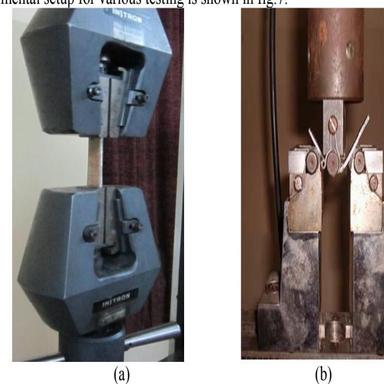
and b shows the Experimental setup of Tensile and Flexural Machine